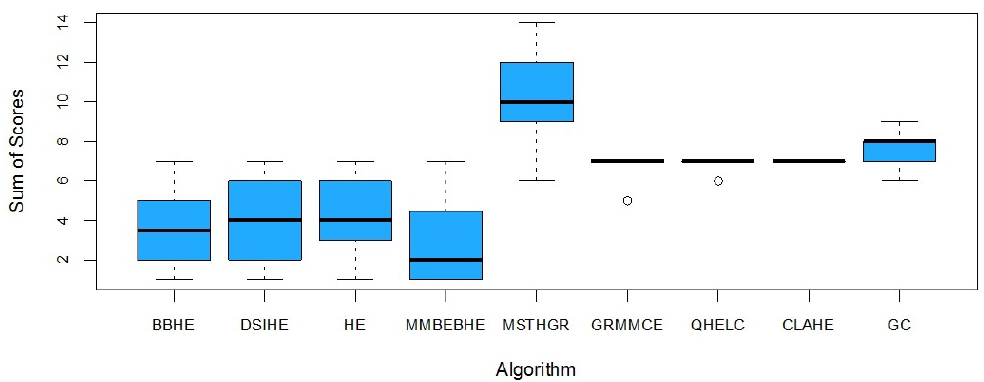
Figure 8. Box and whiskers diagram. Distribution of the sum of scores according to the enhancement algorithm